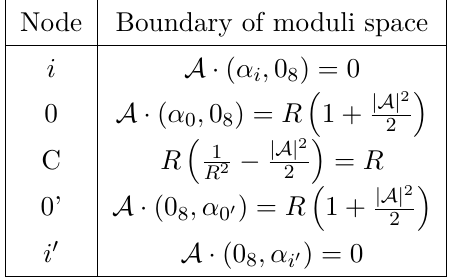
Table 2 . Equations defining the co-dimension one boundary planes in moduli space corresponding to each node of the EDD, where the nodes 0 and 0’, given in (2.13) have winding charge (i.e. Z is that of eq.